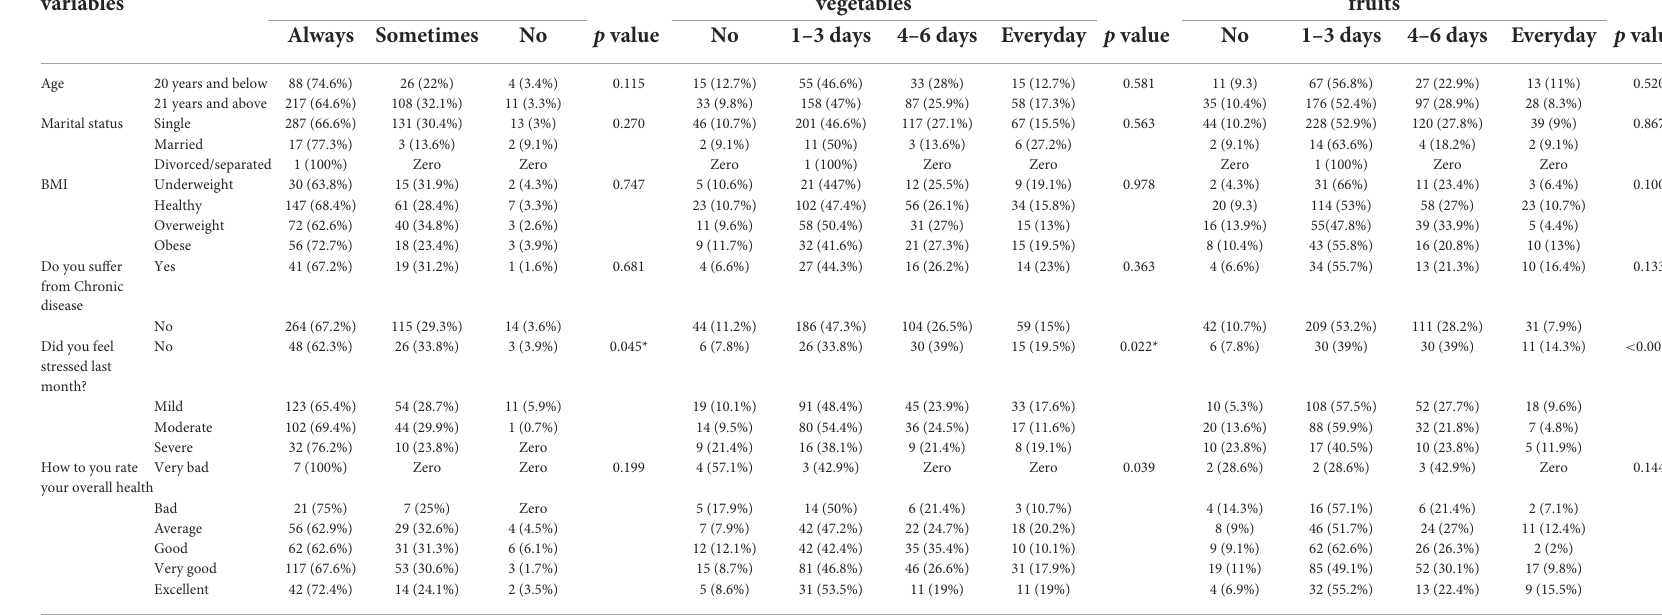
TABLE 2 Vegetable, fruits eating pattern and adding salt to food among male students of Najran